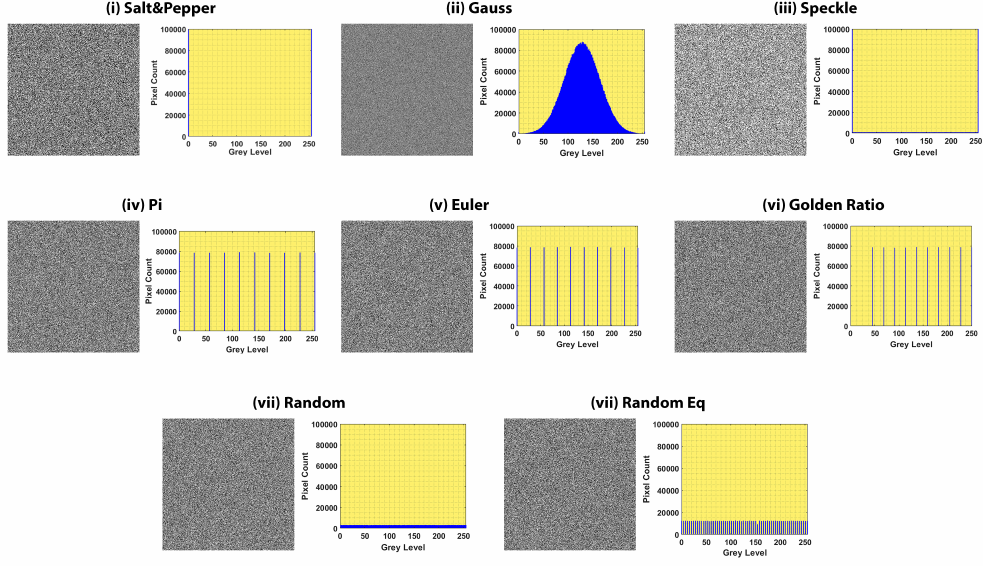
Figure 1. Partial bitmap representation of the synthetic noise patterns and their intensity